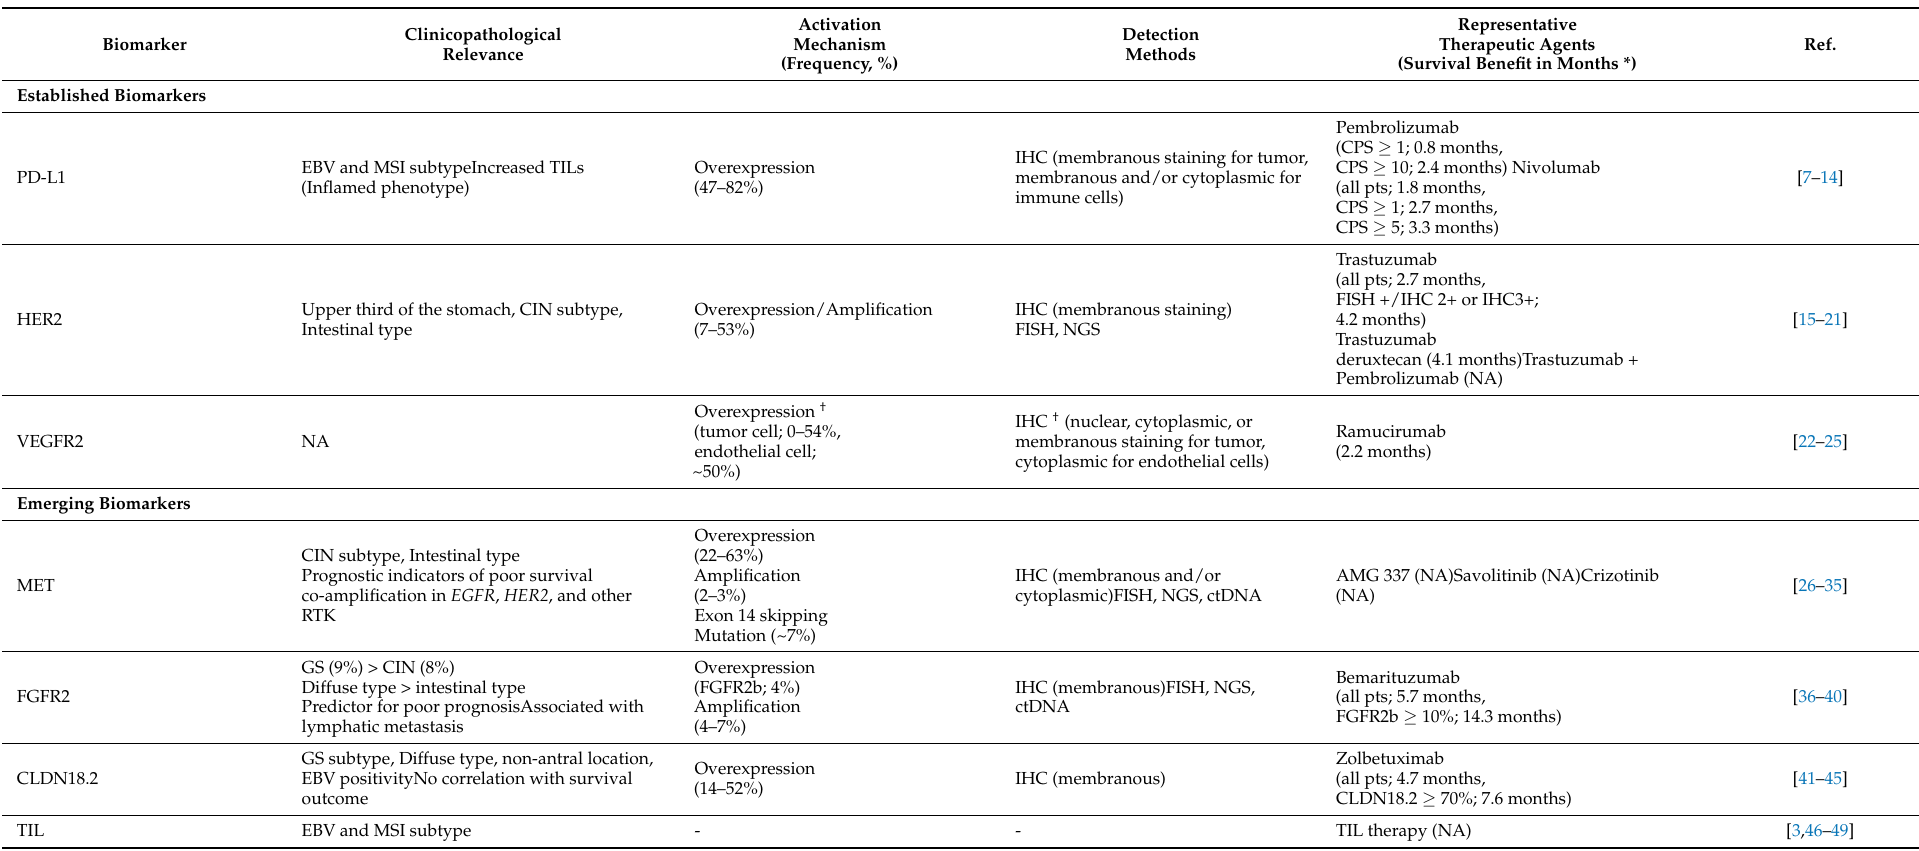
Table 2. Key biomarkers in gastric cancer with their clinicopathological relevance, alterations, diagnosis, and targeted